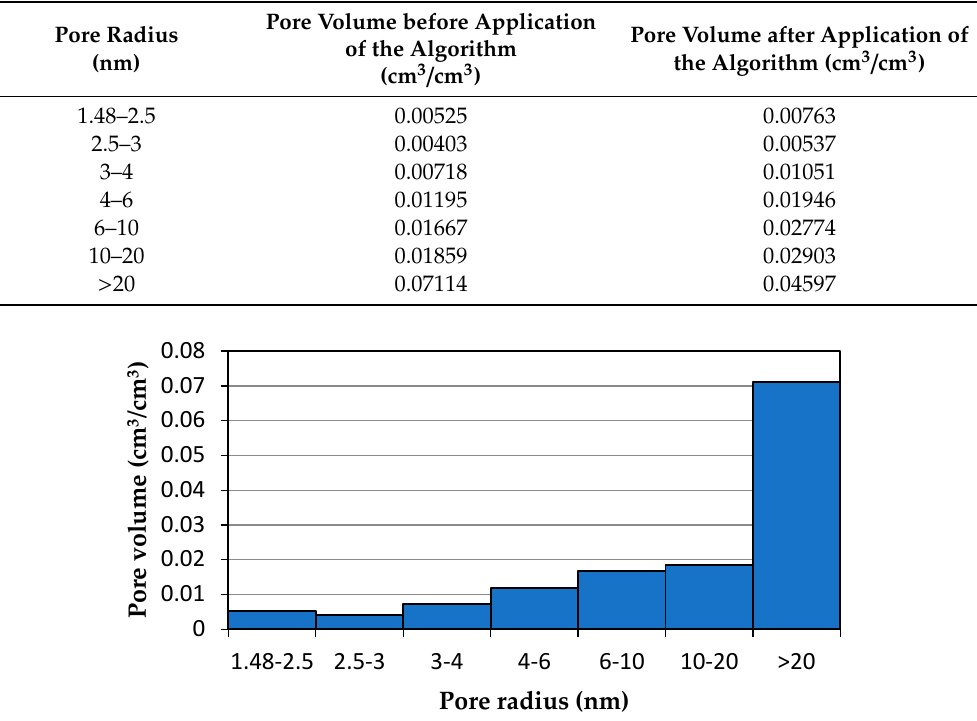
Figure 14. Pore size distribution that was obtained with thermoporometry on the basis of phase transition energy distribution, without taking thermal inertia into account.